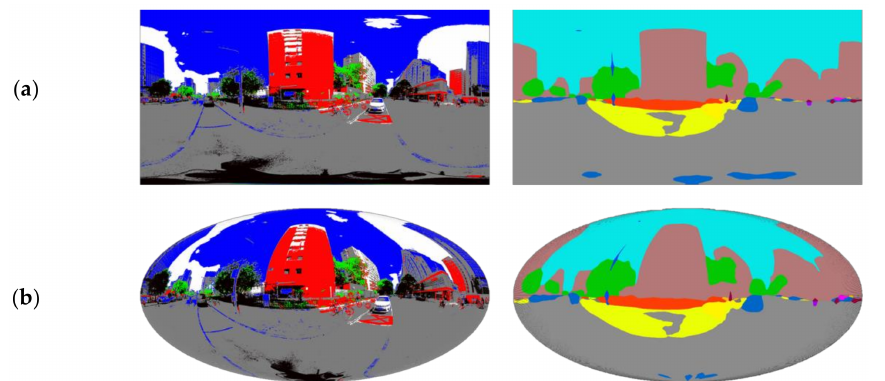
Figure 3. Examples of the Hammer Projection transformation results: ( a ) panoramic images; ( b ) projection transforma- tion